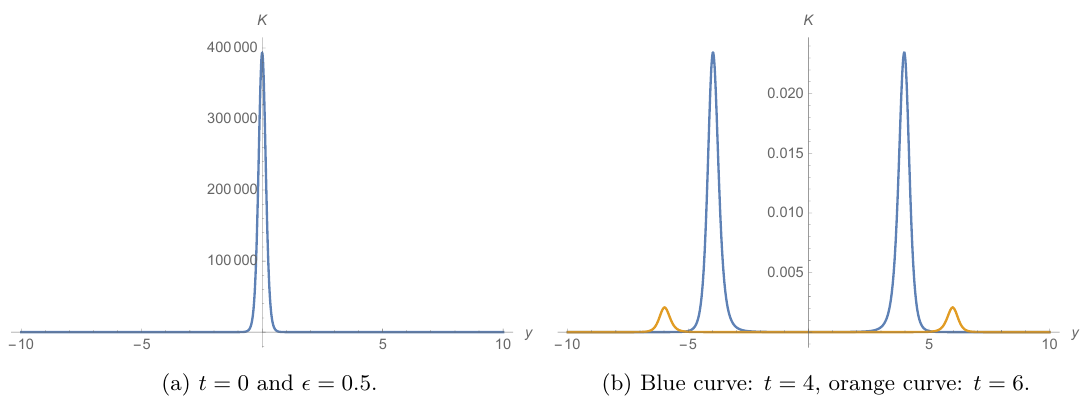
(b) Blue curve: t = 4 , orange curve: t = 6 . Figure 5 . Kretschmann curvature density for the quench created by Riemann curvature R tyty placed at the origin at times t = 0 , t = 4 and t = 6 . We choose (cid:15) = 0 . 5 . The Kretschmann curvature density travels at the speed of light as spherical